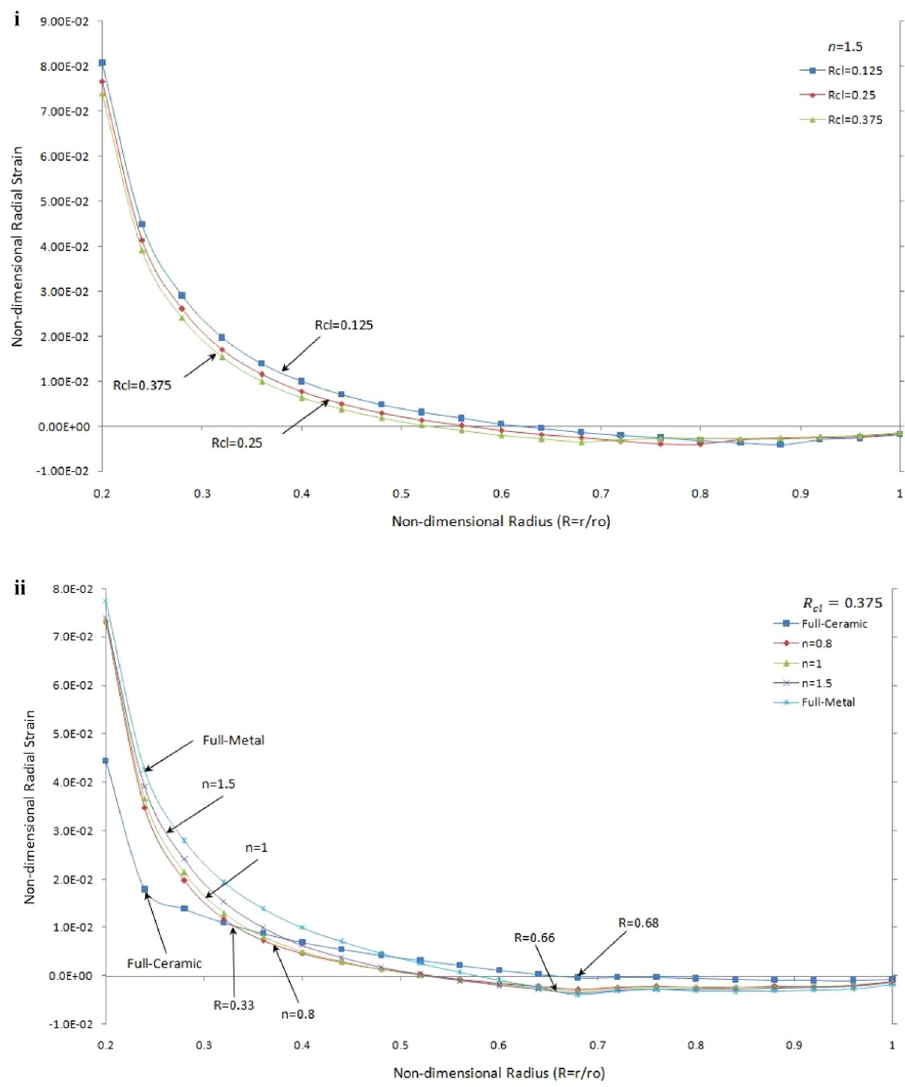
Figure 8. Non-dimensional radial strain versus the non-dimensional radius of one side contact with thermo- mechanical load (i) in the FGMs rotating brake disk with different R cl and n = 1.5 (ii) in the rotating brake disk with R cl = 0.375 and different values of the grading index